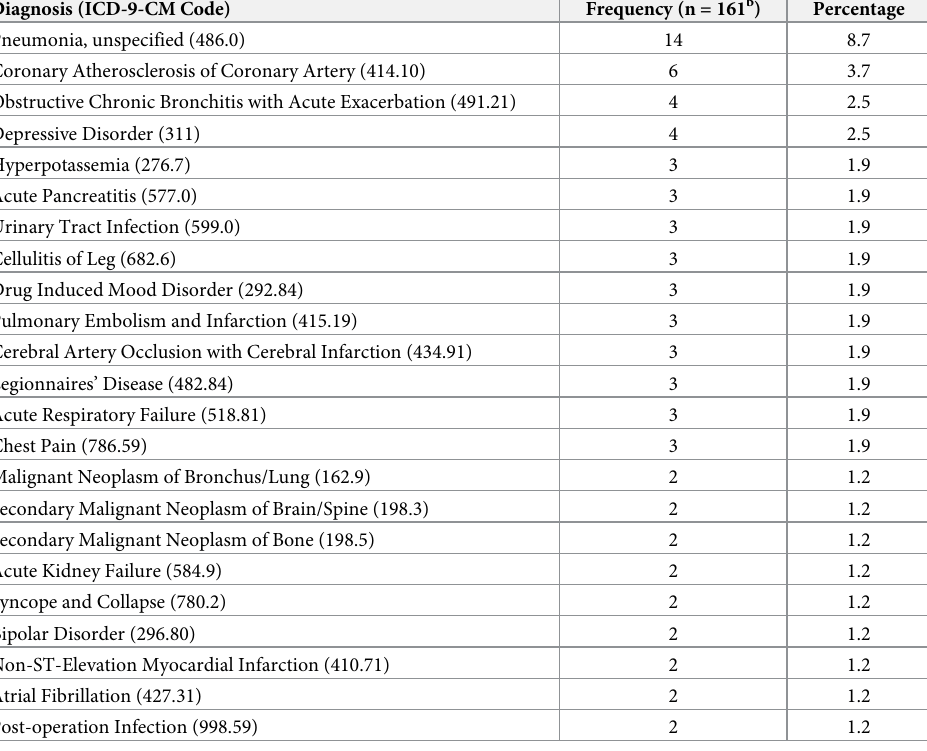
Table 2. Frequency a of primary ICD-9-CM discharge diagnosis code of first subsequent hospitalization after inci- dent Legionnaires’ disease hospitalization among patients to any U.S. VA medical facility,